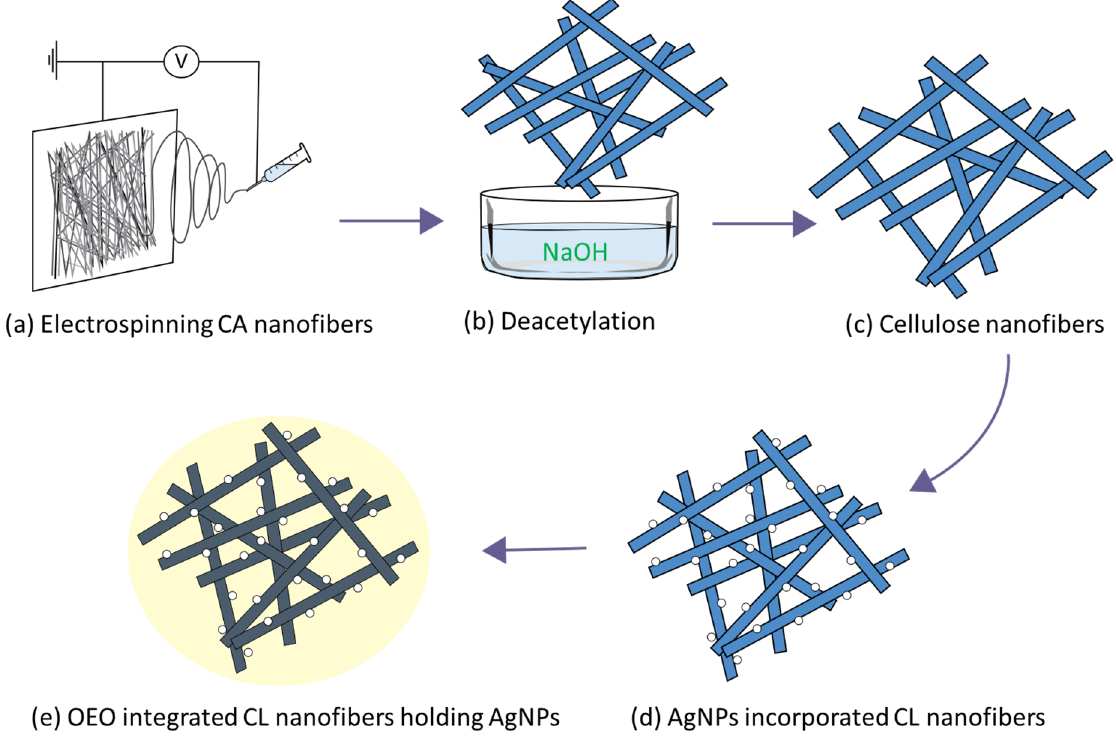
Scheme 1. Schematic representation of the fabrication of orange essential oil-integrated cellulose nanofibers containing silver nanoparticles.